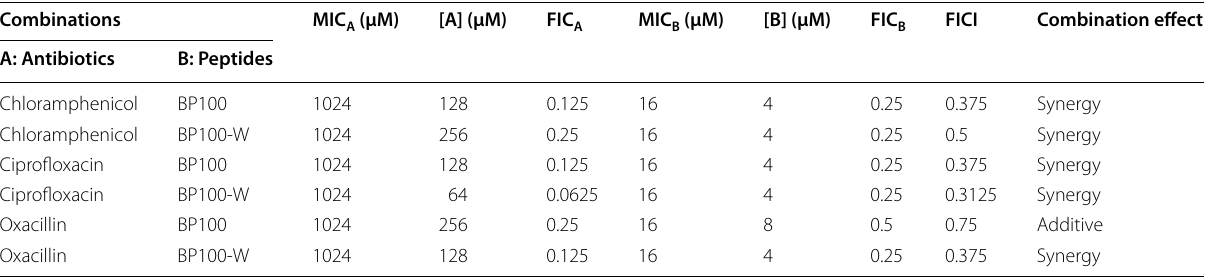
Table 3 Fractional inhibitory concentration index (FICI) a of peptides in combination with conventional antibiotics against multidrug- resistant Pseudomonas aeruginosa (MDRPA) (CCARM